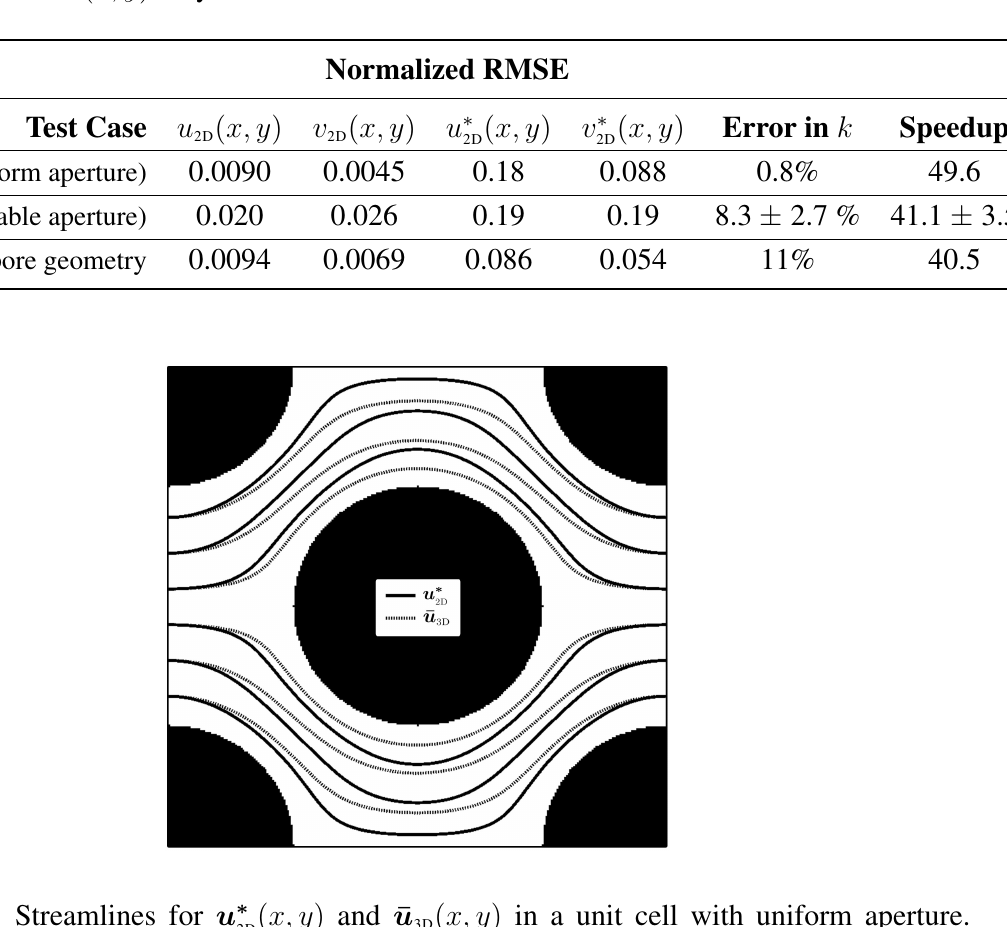
( x, y ) and ¯ u ( x, y ) in a unit cell with uniform aperture. Figure 3. Streamlines for u ∗ 3D 2D ( x, y ) are indistinguishable from those for ¯ u ( x, y ) and are not Streamlines for u 2D 3D